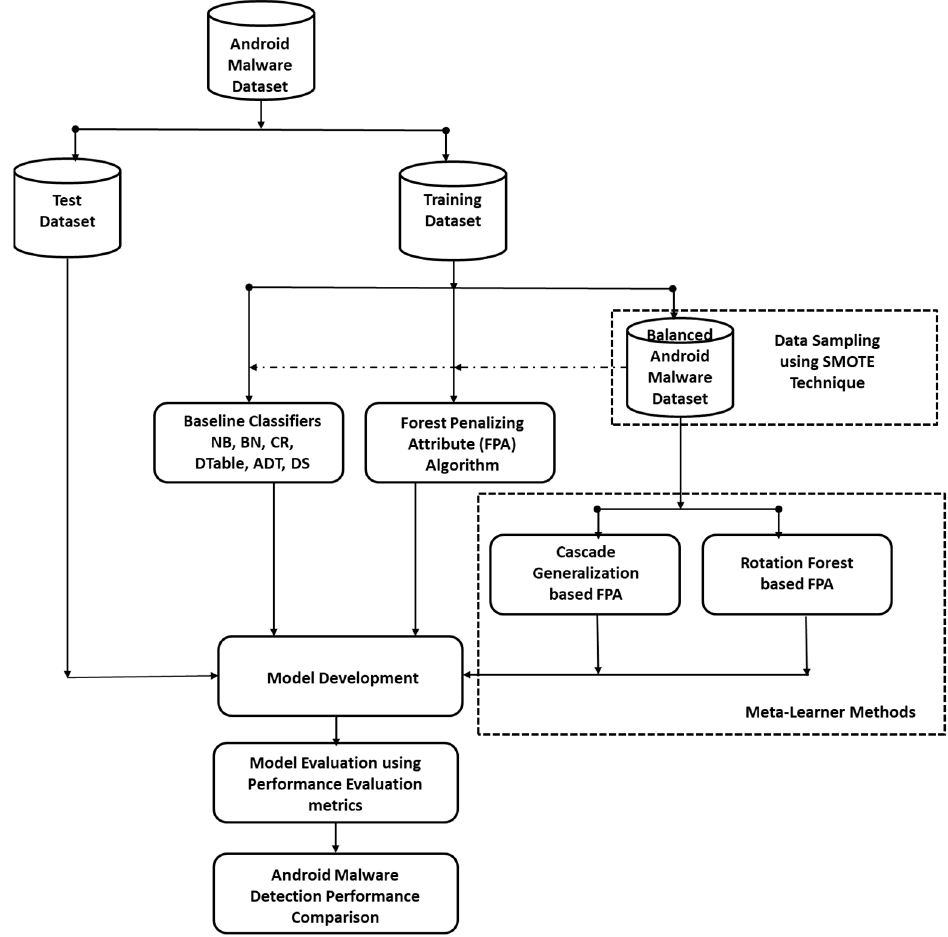
Figure 1. Experimental Framework.